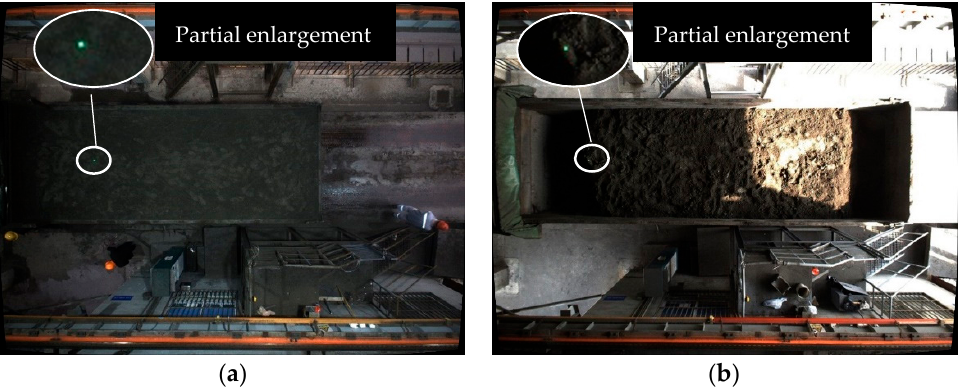
Figure 17. The imaging diagram of the laser spot on the mineral powder plane. ( a ) Cloudy day. ( b ) Sunny day.